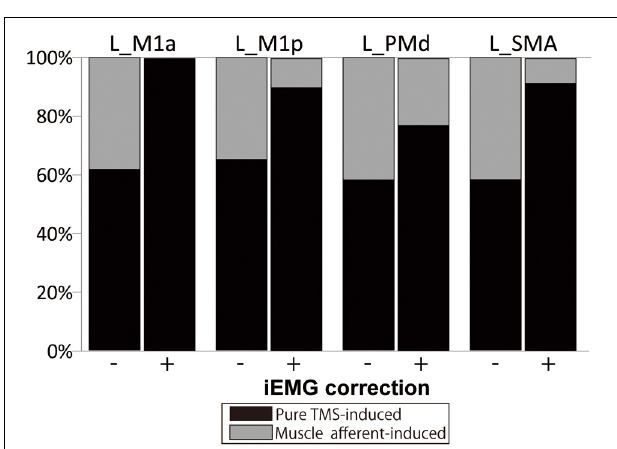
FIGURE 4 | Percentage of fMRI signals ascribed to the “pure” TMS- and muscle afferent-induced activity within supra-TMS-induced activity. Data are shown for representative motor areas. Black , percentage of the contrast Supra-TMS minus Motor-MNS. Gray , percentage of the contrast Motor-MNS minus implicit baseline. ( − ), without iEMG correction. ( + ), with iEMG correction. L , left; M1a and M1p , anterior and posterior subdivisions of primary motor cortex; PMd , dorsal premotor cortex; SMA , supplementary motor